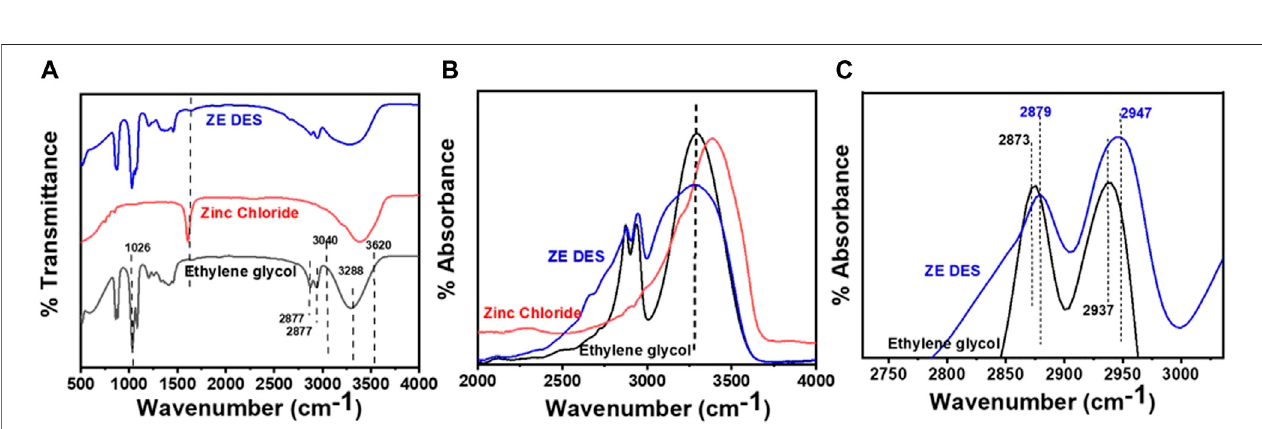
FIGURE 2 | (A) Fourier transform infrared spectra of neat ethylene glycol, ZnCl 2 , and their eutectic mixture (ZE DES). (B) − OH and (C) -methylene stretching regions.